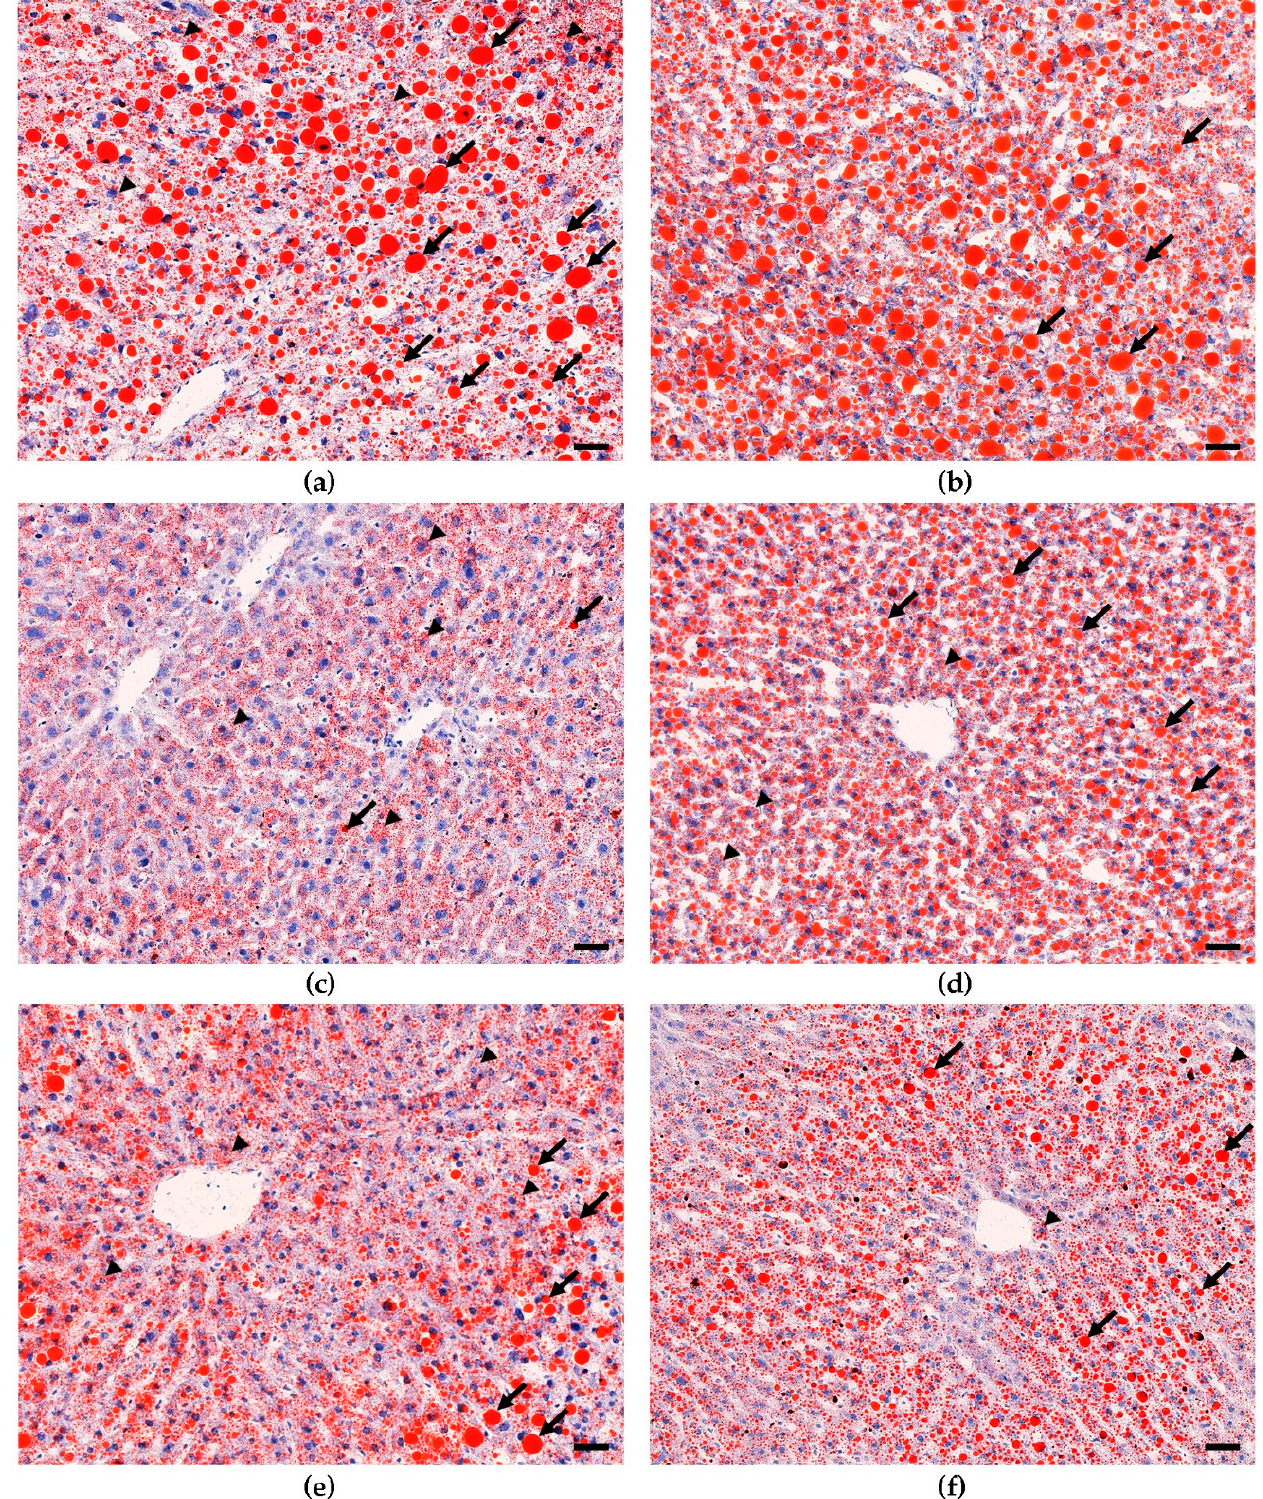
Figure 3. Comparison of lipid accumulation in male and female Oil Red O-stained liver sections across different diets. ( a ) Male 0%; ( b ) Female 0% bean; ( c ) Male 70% bean; ( d ) Female 70% bean; ( e ) Male low fat; ( f ) Female low fat. Extracellular lipid (arrows); intracellular lipid (arrowheads); magnification 200×; bars = 40 µm.